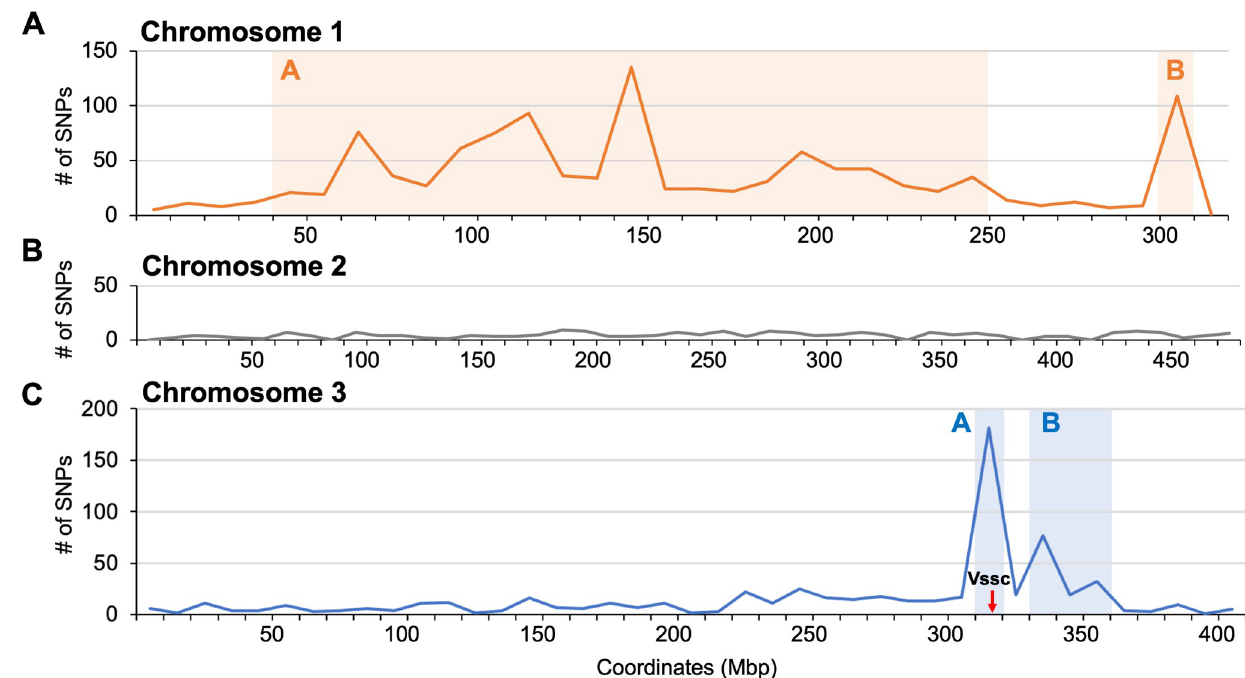
Fig 3. The distribution of potentially resistance associated SNPs across three chromosomes within a 10 Mb window size. The two resistance loci detected on chromosome 1 and chromosome 3 are shown by the orange and blue shaded areas, respectively. Red arrow indicates the coordinate of Vssc on chromosome